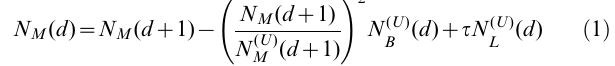
d ð Þ , N U ð Þ d ð Þ , N U ð Þ d ð Þ for the universal network and N M d ð Þ , N B d ð Þ , N L d ð Þ for species-specific M B L